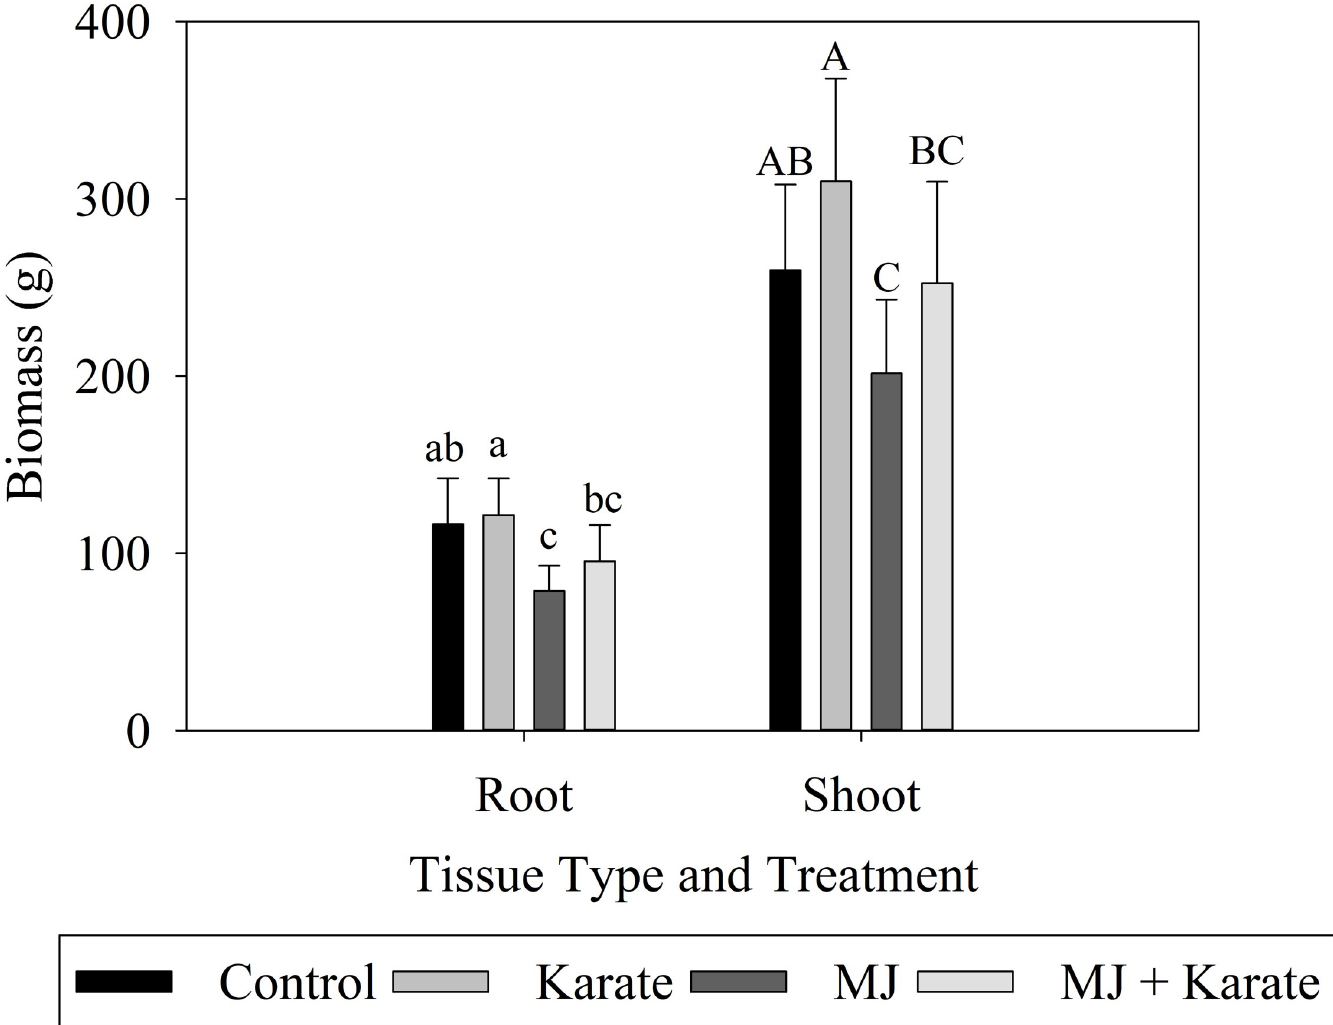
Fig 4. Effects of factorial combinations of methyl jasmonate seed treatment (MJ) and insecticide application (Karate) on root and shoot biomasses (grams per plant ± S.E.) of rice plants over five sampling dates in 2017. Average root (A) and shoot (B) masses of plants in each treatment: MJ–treated (MJ), insecticide-treated (Karate), MJ- and insecticide-treated (Both), and non-treated plots (Control), are shown.